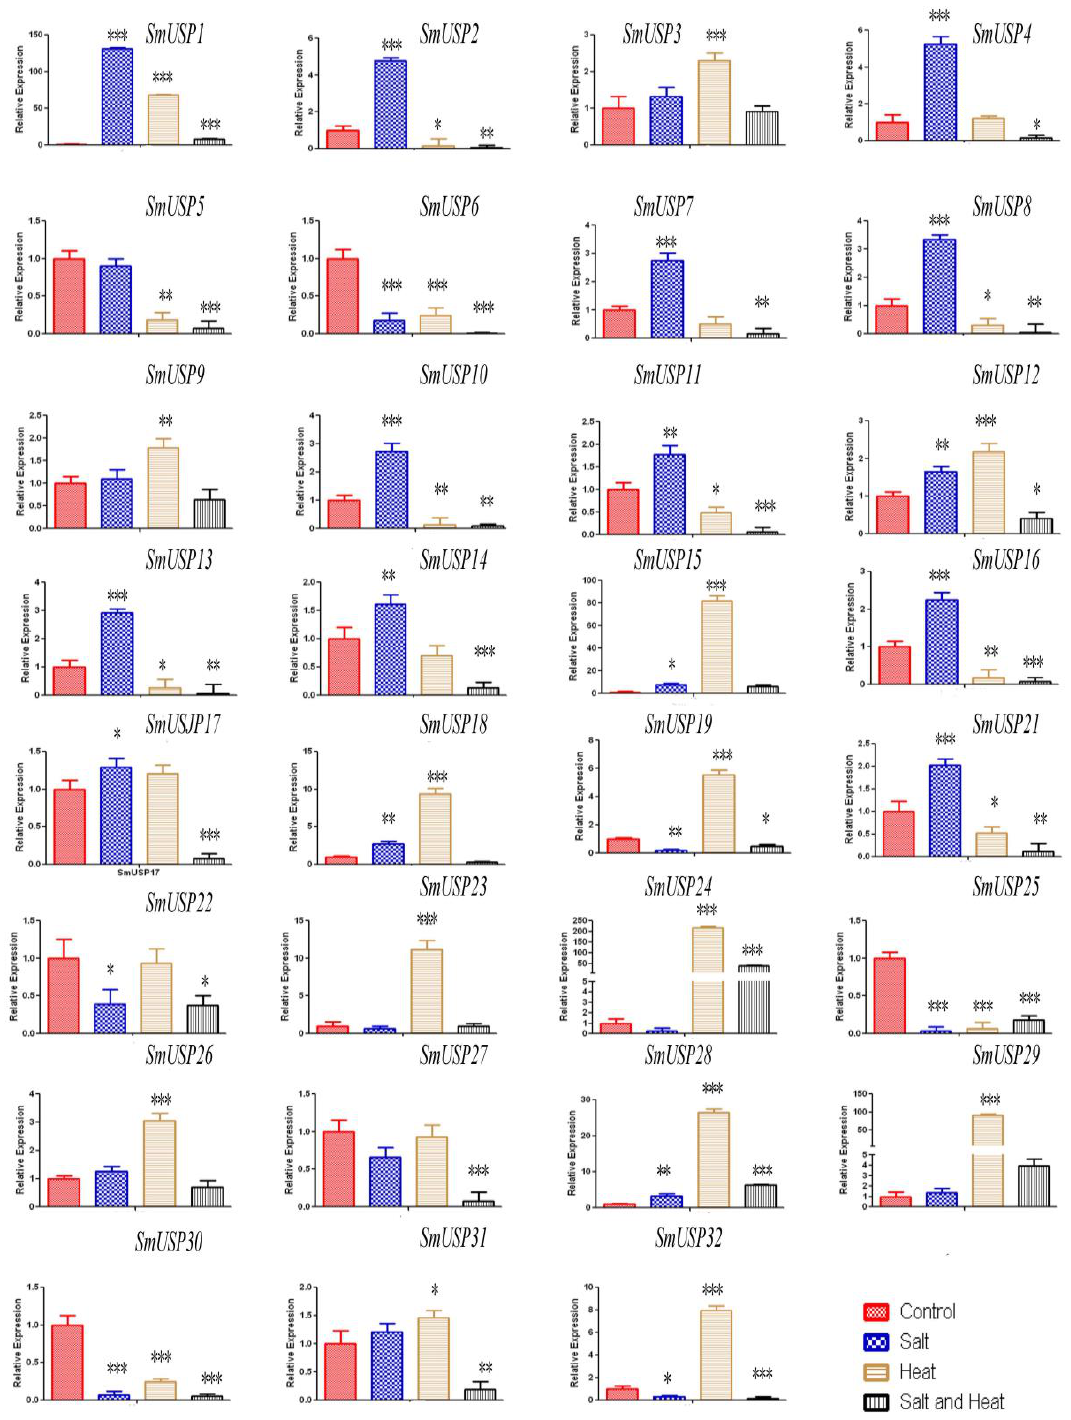
Figure 6. Expression of 32 SmUSP genes under different stress conditions. Based on comparative 2 − ∆∆ C(T) method, all levels are relative to control. For each gene, *, **, and *** indicate that expression is significantly different from control at p < 0.5, 0.1, and 0.01, respectively. All data were presented as the means ± Standard Deviation (SD) of at least three replicates.